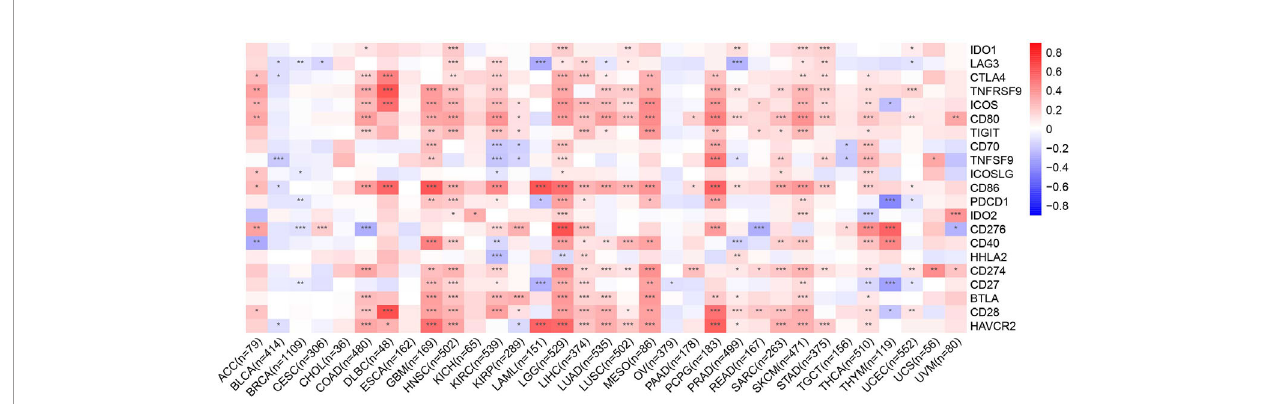
FIGURE 6 | Heatmap representation of the correlation between CMTM6 expression and checkpoint-associated genes across 33 cancer types. Red color represents positive correlation and blue color represents negative correlation. *p < 0.05; **p < 0.01; ***p < 0.001.